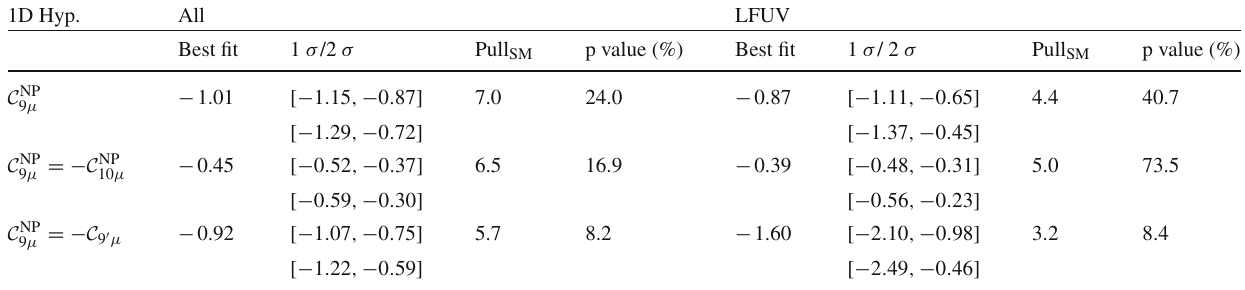
Table 2 Most prominent 2D patterns of NP in b → s μμ . The last five rows correspond to Hypothesis 1: ( C NP